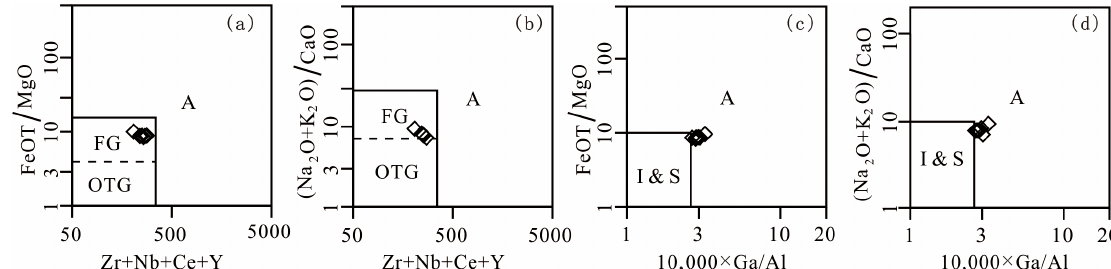
Figure 8. Discrimination diagrams of granite type for the MG from Wulandele Mo deposit: ( a ) FeOT/MgO vs. Zr + Nb + Ce + Y; ( b ) (Na 2 O + K 2 O)/CaO vs. Zr + Nb + Ce + Y; ( c ) FeOT/MgO vs. 10,000×Ga/Al; ( d ) (Na 2 O + K 2 O)/CaO vs. 10,000×Ga/Al. FG—Fractionated Granite; OGT—unfractionated M-, I-, and S-type granites; A—A-type granite (after [26]).